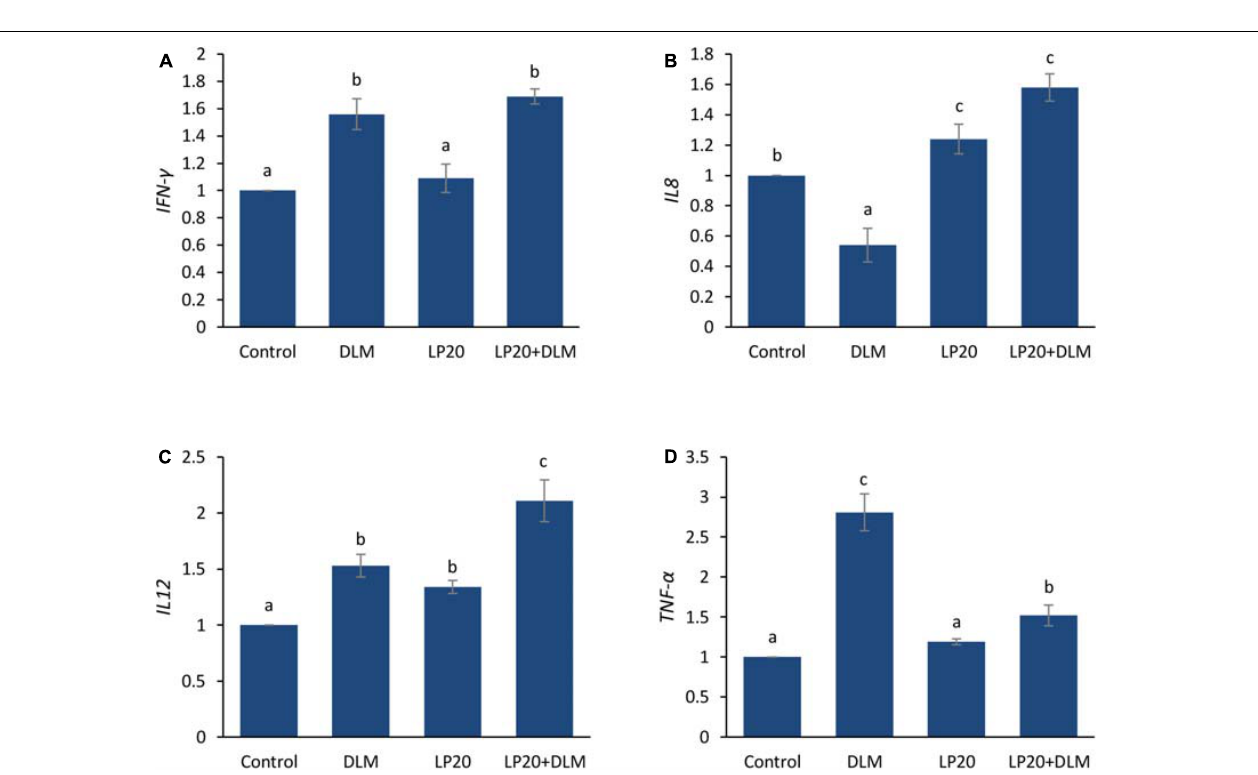
FIGURE 4 | Relative expression of immune-related genes ( IFN- γ , IL-8 , IL-12 , and TNF- α ) of Nile tilapia exposed to DLM and challenged with A. hydrophila and fed diets with or without LP20 for 30 days. Values are expressed as mean ± SE from triplicate groups (six fish per group). Bars with different letters indicate significant difference from the control group ( P <